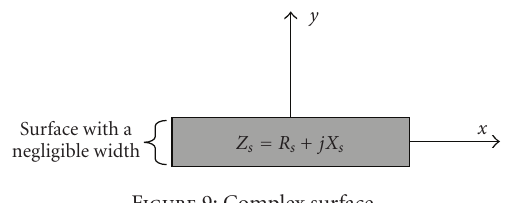
Figure 9: Complex surface.